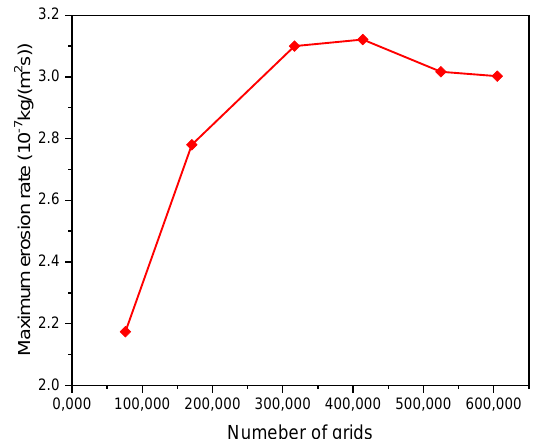
Figure 6. Analysis of mesh independence by comparing the maximum erosion rate with different grid quantities.